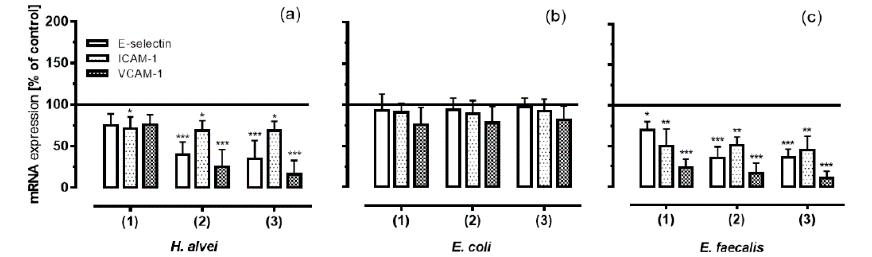
Figure 5. mRNA expression levels of E-selectin, ICAM-1 and VCAM-1 on HUVECs under LGI conditions and long-term incubation ACNs fermented by ( a ) H. alvei ; ( b ) E. coli and ( c ) E. faecalis . After incubation of Caco-2 cells with fermented ACNs from the lag- (1), log- (2) and stat-phase (3), transwell inserts were removed, and the co-cultured HUVECs were further incubated for 20 h. Thereafter, cells were stimulated with 1 ng/mL TNF- α for 3 h (LGI). After TNF- α stimulation, mRNA expression levels were measured as described in the Materials and Methods section. Corresponding controls (maximal expression after LGI) were set as 100%. Values are given as the mean ± SD ( n = 3). Differences were significant at * p < 0.05, ** p < 0.01 and *** p < 0.001.